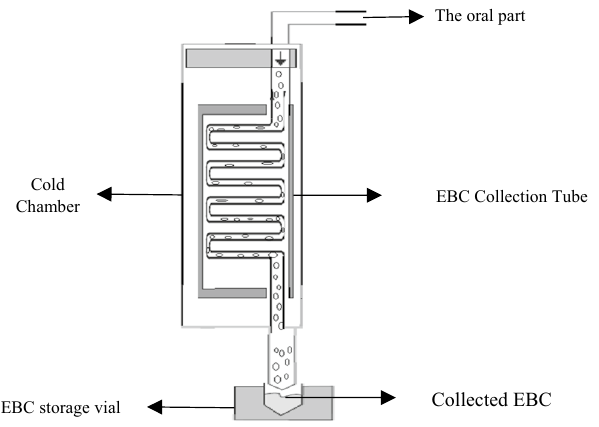
Figure 1. schematic of the EBC collector designed in this